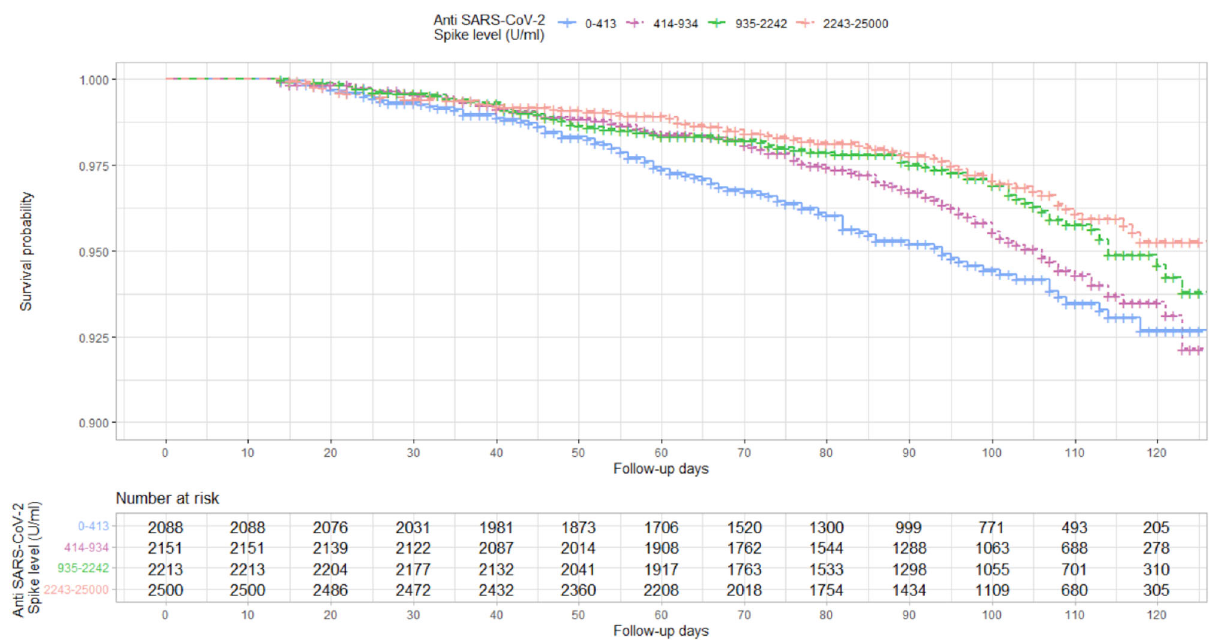
Fig. 3 | Kaplan – Meiersurvivalcurveofriskofbreakthroughinfectionby Spike antibodylevelinquartiles. The fi rstanti-Slevelforparticipantsaftertheirsecond dose of vaccine and 1st July 2021 wasused. The risk of breakthrough infections for the lowest quartile (upper limit413U/ml)began to divergefrom the riskforhigher